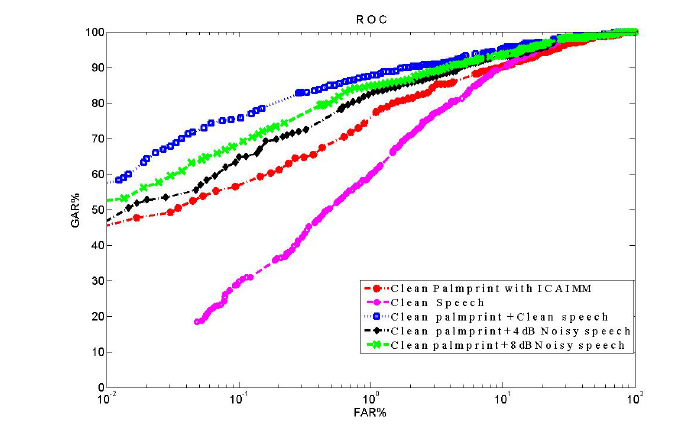
Figure 10. ROC curves for match score level fusion of clean palmprint using ICA I MM with speech (both clean and noisy).